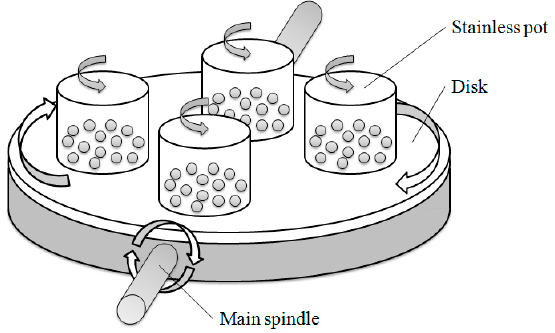
Figure 1. Schematic representation of an all-dimensional planetary ball mill.